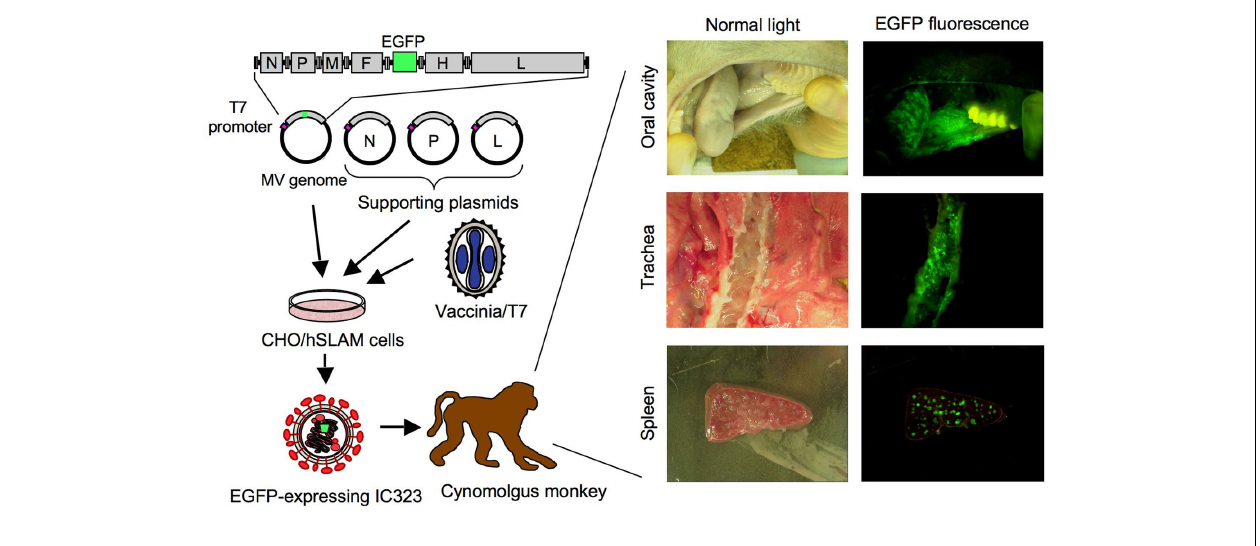
proteins, respectively, under the control of theT7 promoter. After infection with vaccinia virus expressing theT7 RNA polymerase, wild-type MV expressing EGFP can be recovered by mixing with B95a cells. EGFP fluorescence in tissues and organs of infected monkeys can be detected using a fluorescence